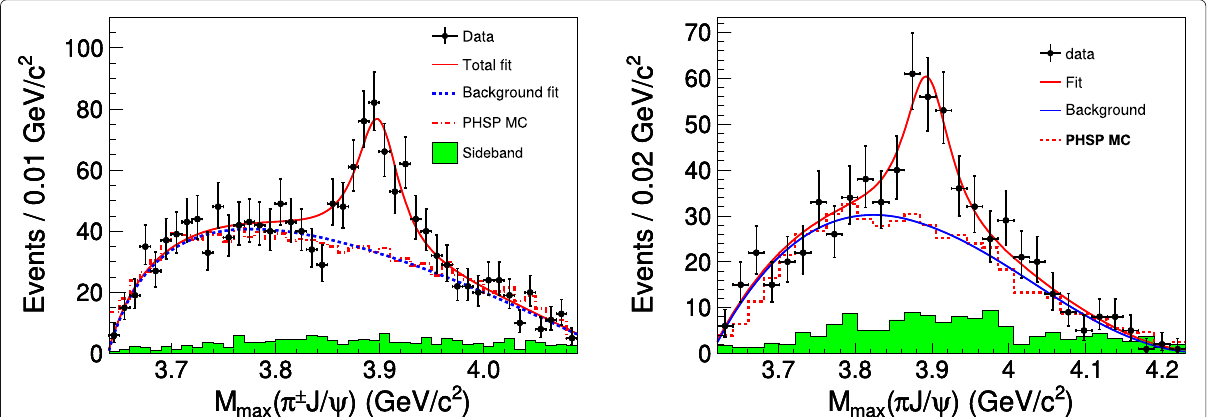
Fig. 6 The M (π ± J /ψ) mass distribution from BESIII (left) and Belle (right) experiments, where the Z c ( 3900 ) resonance is